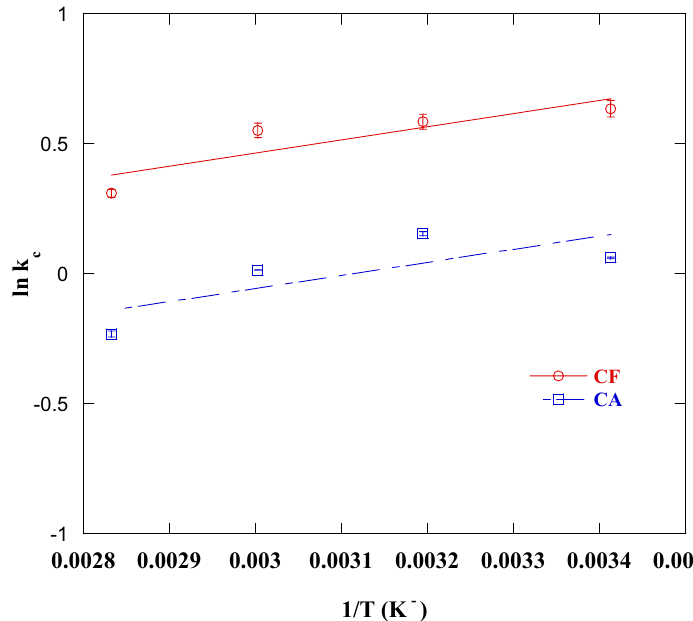
Figure 14. Van’t Hoff plot for Disperse red 60 dye adsorption onto CF and CA.